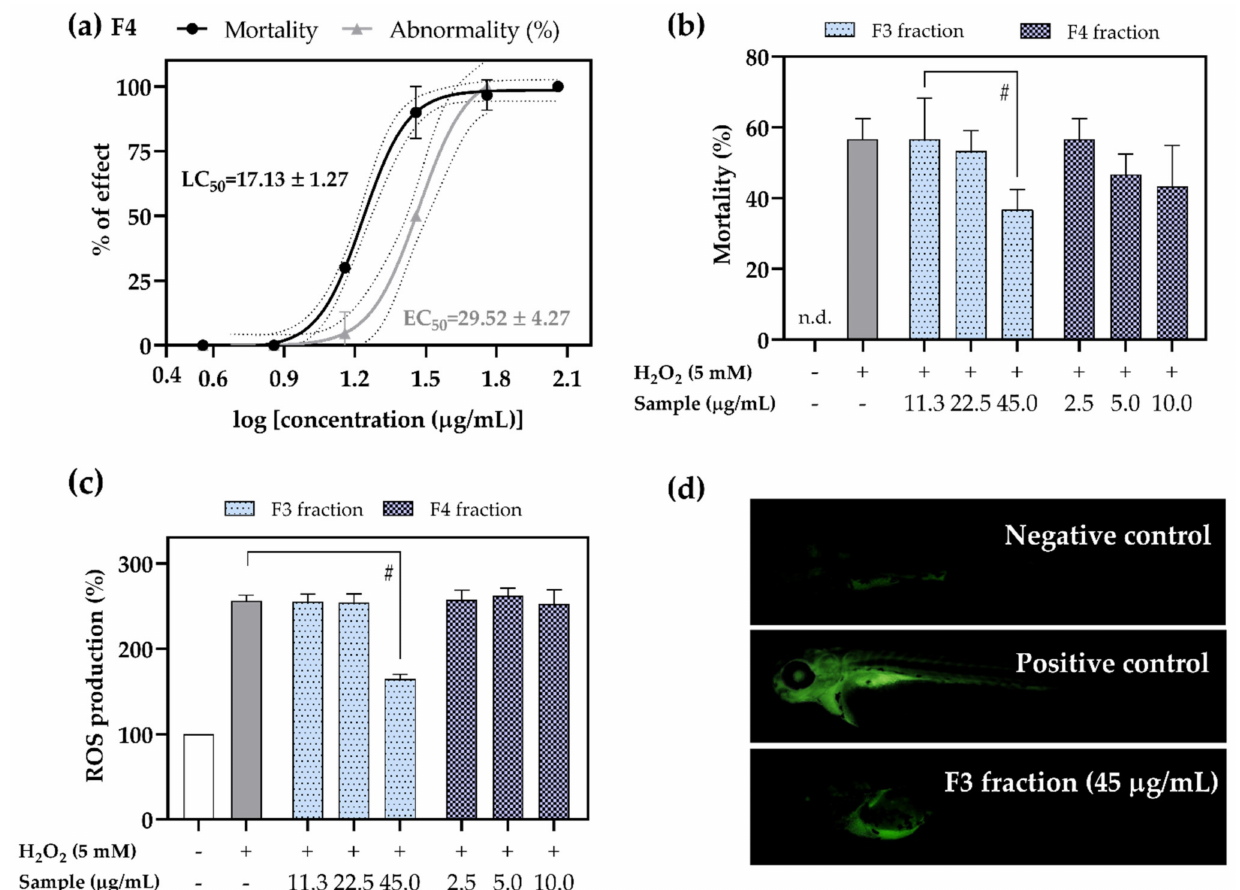
Figure 8. Acute toxicity of tested F3 and F4 fractions, along with their antioxidant potential in vivo: ( a ) concentration–response curves used for the calculations of D. rerio mortality and abnormality rates after 96 h of exposure to F4. Dotted lines represent 95% confidence intervals. Protective effect of F3 and F4 on the ( b ) survival and ( c ) ROS production hydrogen peroxide-stressed D. rerio embryos. ( d ) Qualitative analysis of ROS production in live specimens observed under fluorescent microscopy. The results are expressed as mean ± SD of three replicates; # denotes significant differences ( p <